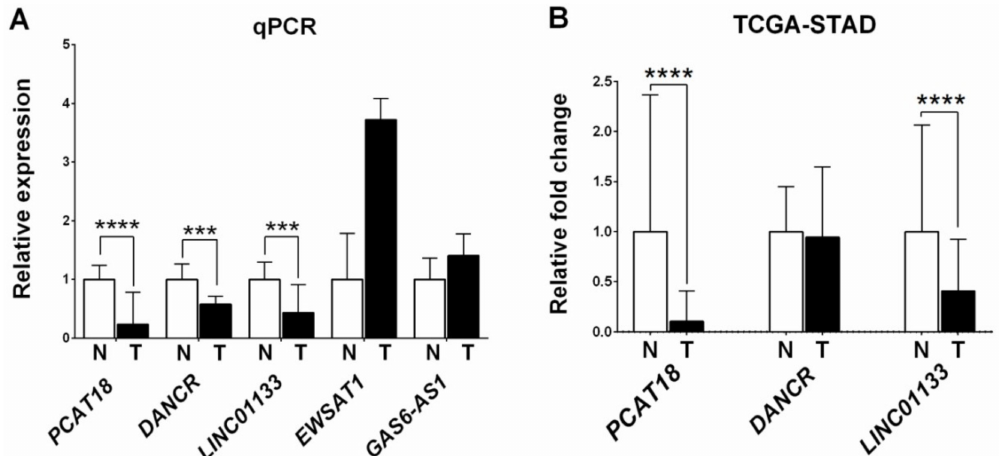
Figure 3. Expression levels of PCAT18 , DANCR , LINC01133 , EWSAT1 , and GAS6-AS1 in GCs and their adjacent normal tissues. ( A ) Expression was measured in 25 GCs and their adjacent normal tissues by real-time qPCR; ( B ) Expression data were retrieved from the TCGA-STAD database. *** p ≤ 0.001, **** p ≤